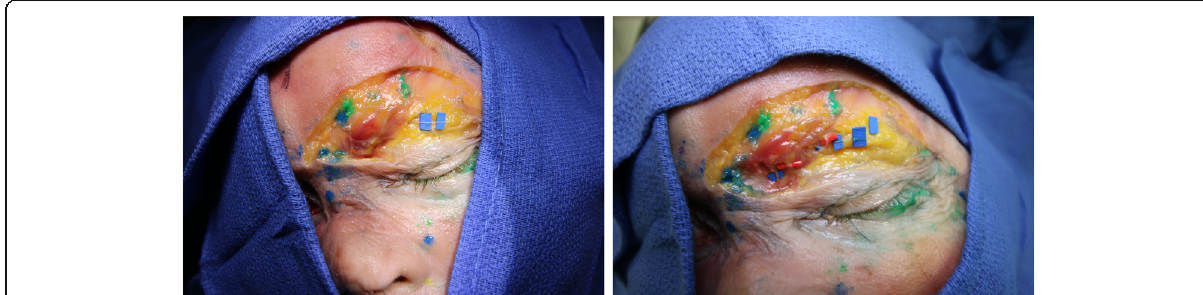
Fig. 1 Anatomic dissection. After skin excision, the corrugator muscle (CSM) is identified. The location of subcutaneous, lateral attachments of the CSM have been marked in green via a transcutaneous injection. Sensitive branches from the supraorbital and supratrochlear nerves crossing the